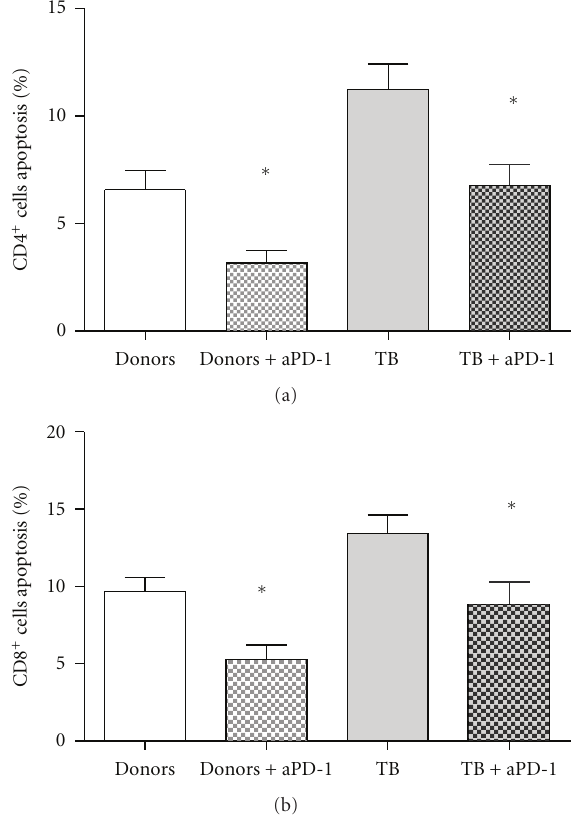
Figure 4: Addition of neutralizing anti-PD-1 antibodies in 3- day MLC stimulated with healthy donor and TB patient DCs was accompanied by decrease in CD3 + CD4 + and CD3 + CD8 + T-cell apoptosis. The number of apoptotic CD3 + CD4 + (M ± S.E.) (a) and CD3 + CD8 + (b) T-cells was determined in allo-MLC stimulated with healthy donor and TB patient DCs in the absence and presence of anti-PD-1 antibodies (5 μ